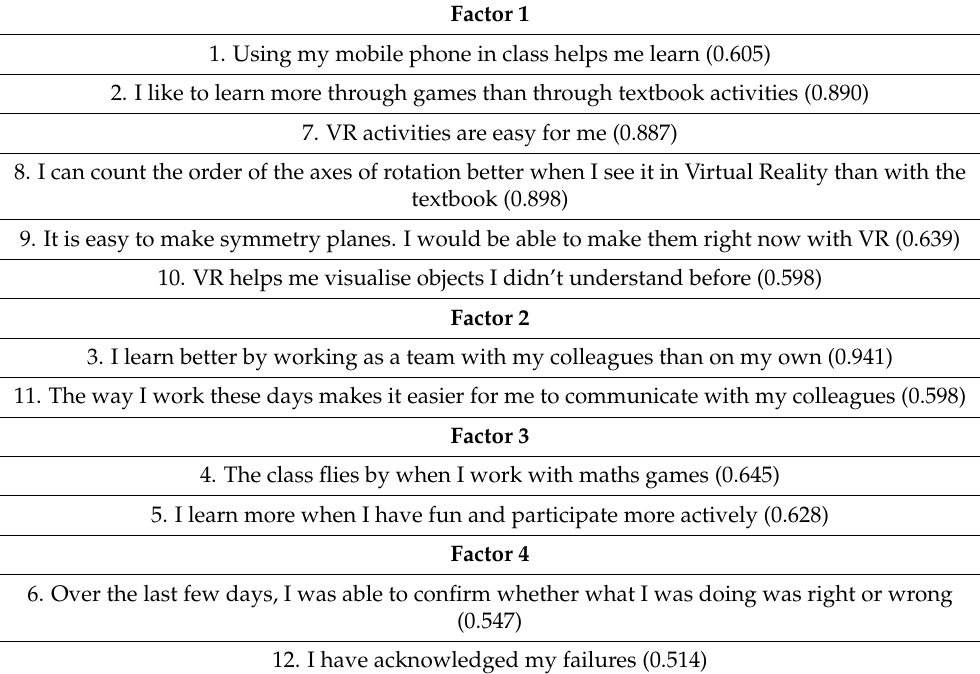
Table 6. Confirmatory factor analysis of clustering questionnaire